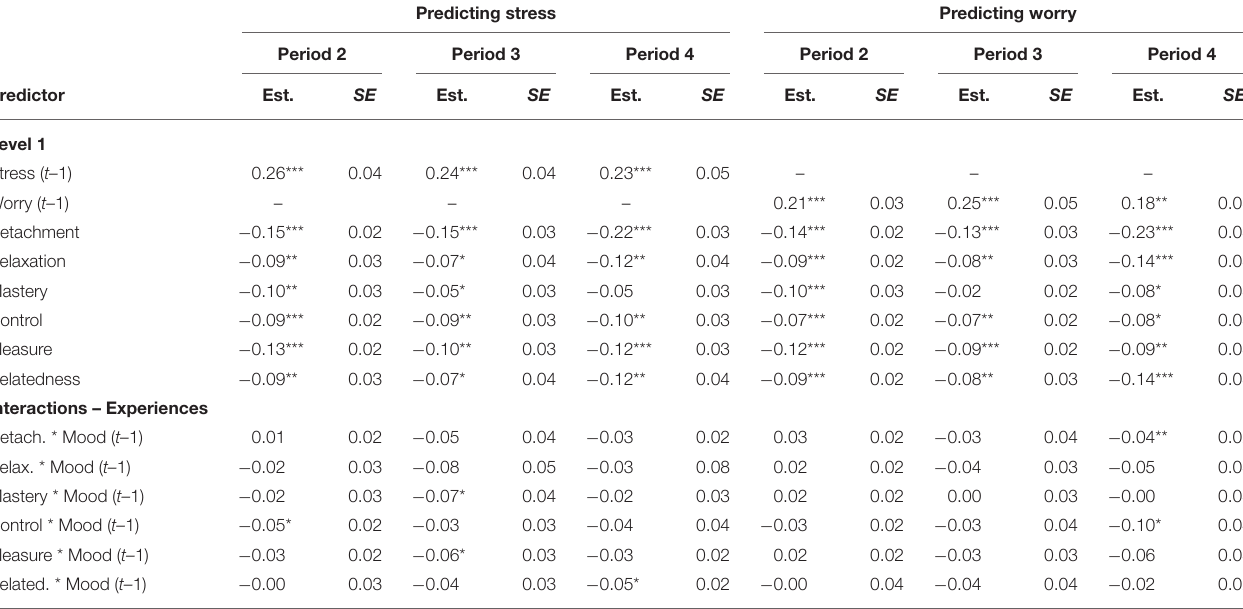
TABLE 2 | Results of the multilevel structural equation model estimating relationships between pandemic-related momentary negative mood and recovery experiences. Predicting stress